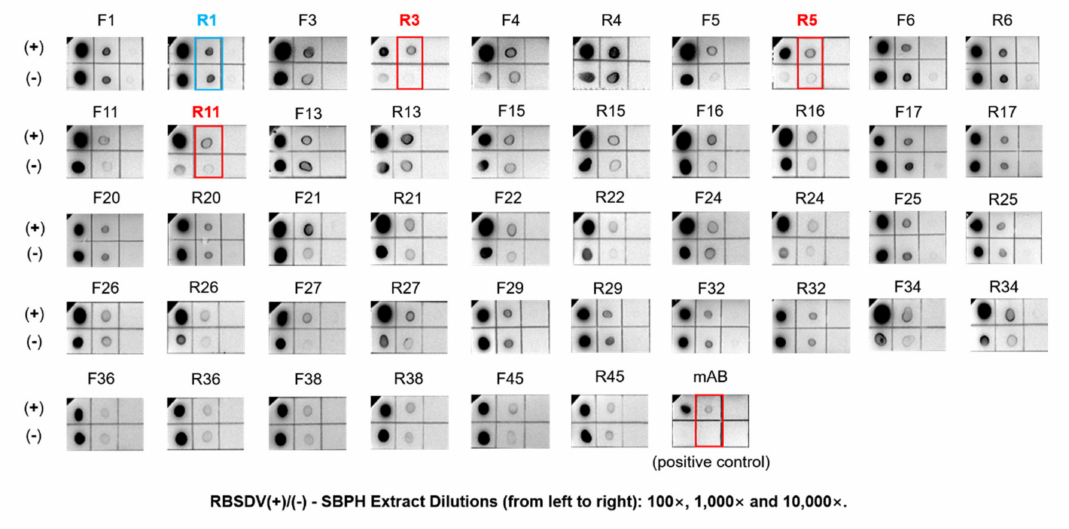
Figure 7. Detection of the RBSDV P10 protein with 46 biotinylated putative aptamers by Dot-ELISA. Total proteins (1 mL) extracted from either 100 mg RBSDV-infected small brown planthoppers, as SBPH ( + ) or RBSDV-free SBPH ( − ), were serially diluted, from left to right panels in each block, 100, 1000 and 10,000 times, respectively. An amount of 1 µ L each of the 3 dilutions from RBSDV-infected SBPH ( + ) proteins (upper 3 blocks) and RBSDV-free SBPH ( − ) proteins (lower 3 blocks) were dot-blotted and detected by 1 µ g / mL each of putative aptamers. The anti-RBSDV P10 protein monoclonal antibody (mAB, 1 µ g / mL) was used as a positive control probe to detect the RBSDV P10 protein. The R1 aptamer was selected as a negative probe and aptamers R3, R5 and R11 were selected as positive probes to detect the RBSDV P10 protein in RBSDV( + )-SBPH midgut subcellular localization